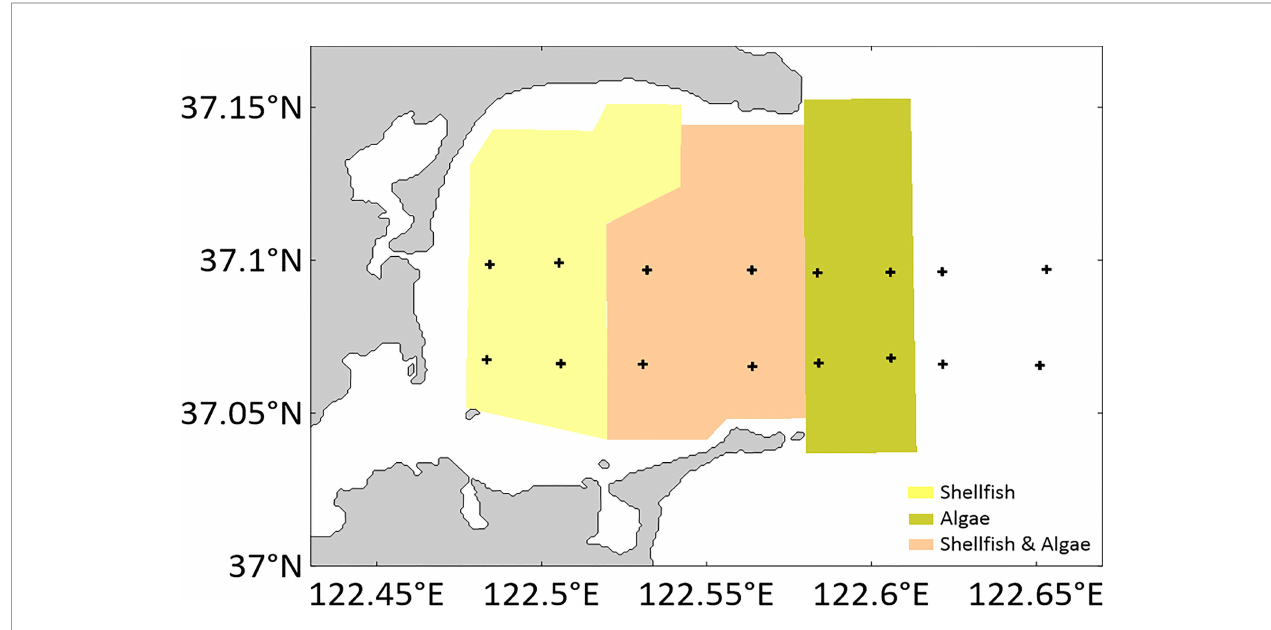
FIGURE 1 | Sampling stations in Sanggou